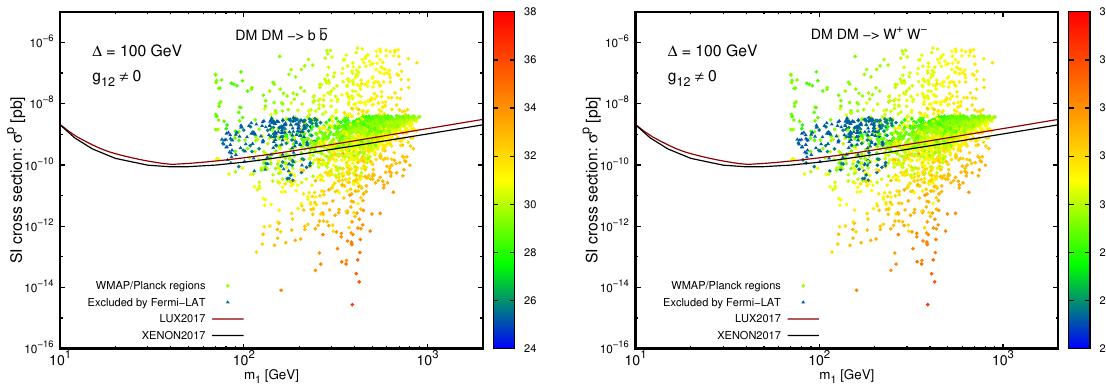
Figure 10 . The DM-proton (SI) scattering cross section as a function of DM mass for the mass splitting (cid:1) = 100 GeV. The vertical color spectrum indicates the quantity (cid:0) log 10 h (cid:27)v i for DM annihilation into b (cid:22) b (left) and DM annihilation into W + W (cid:0) (right)